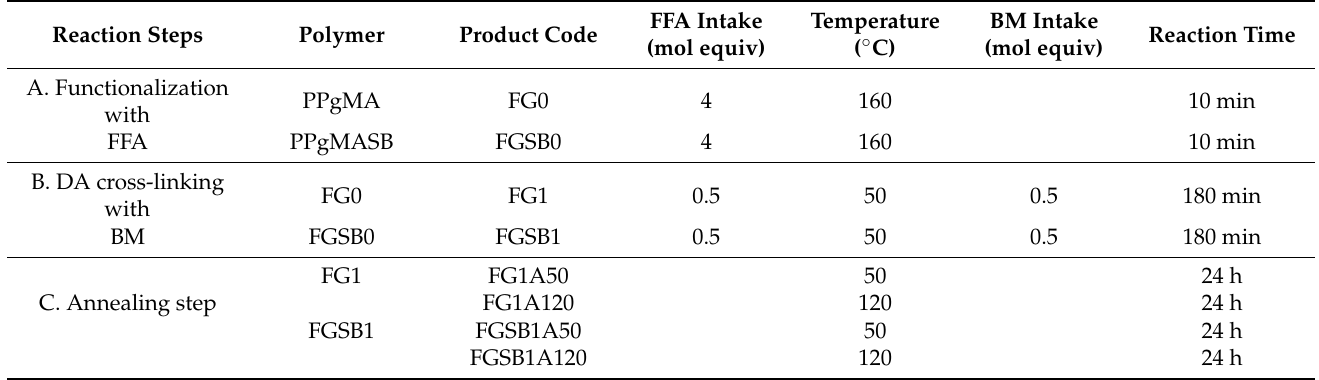
Table 1. Functionalization of maleated PP with FFA, DA reaction with BM, and annealing experimental condition with the corresponding code for each product.